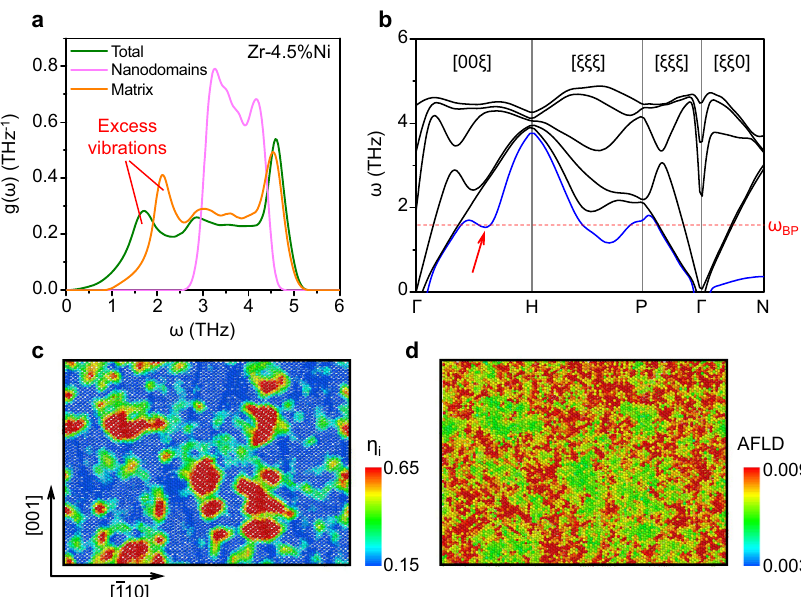
Fig. 4 Structural origin of the BP-like anomaly in strain glass. a VDOS of nanodomains, parent phase matrix as well as the entirety for a strain glass model alloy (Zr – 4.5%Ni). b Phonon spectra of this strain glass alloy at 40 K. The red arrow marks the phonon softening along [001], and the red dash line denotes ω BP . c Spatial distribution of order parameter ( η i ) at the (110) plane for this alloy at 40 K. Red regions correspond to martensitic nanodomains. d Spatial distribution of auto-correlation function of local atomic displacement (AFLD) at 40 K. High AFLD regions (colored red) indicate a high density of excess low-frequency phonon